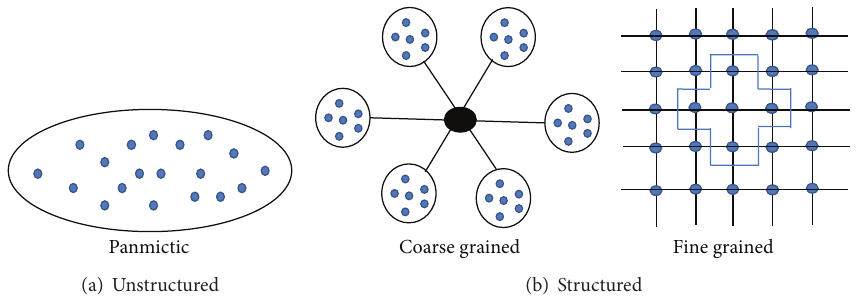
Figure 1: Population